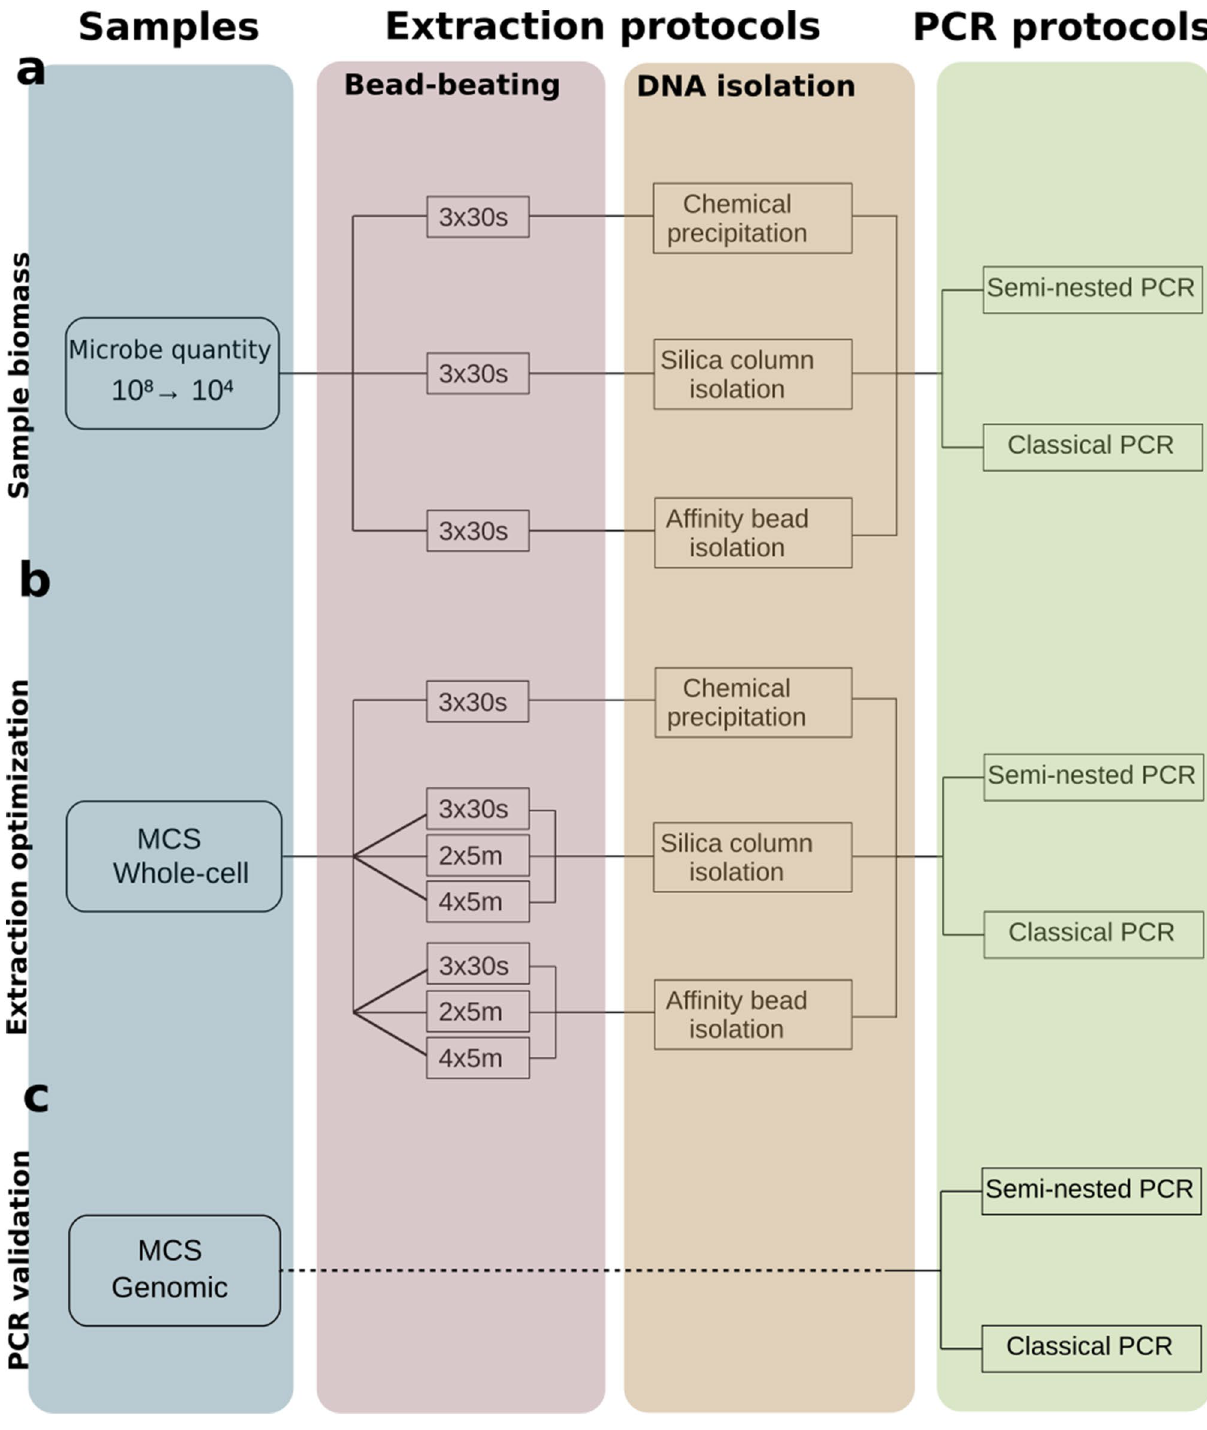
Figure 1. Summary of technical approaches presented in this paper. ( a ) Protocol for low biomass healthy donor stool samples containing 10 8 , 10 7 , 10 6 , 10 5 and 10 4 microbes. ( b ) Protocol tested on whole-cell mock microbial community standard (MCS). ( c ) PCR protocols used on genomic DNA mock microbial community standard. Figures were generated using R 39